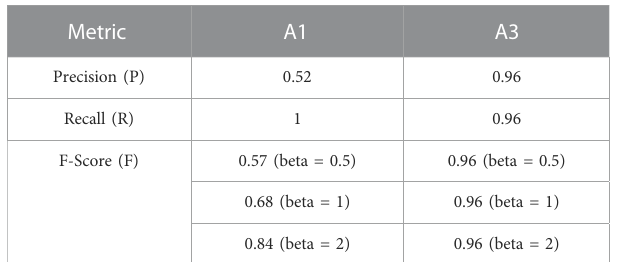
TABLE 2 Detector performance.